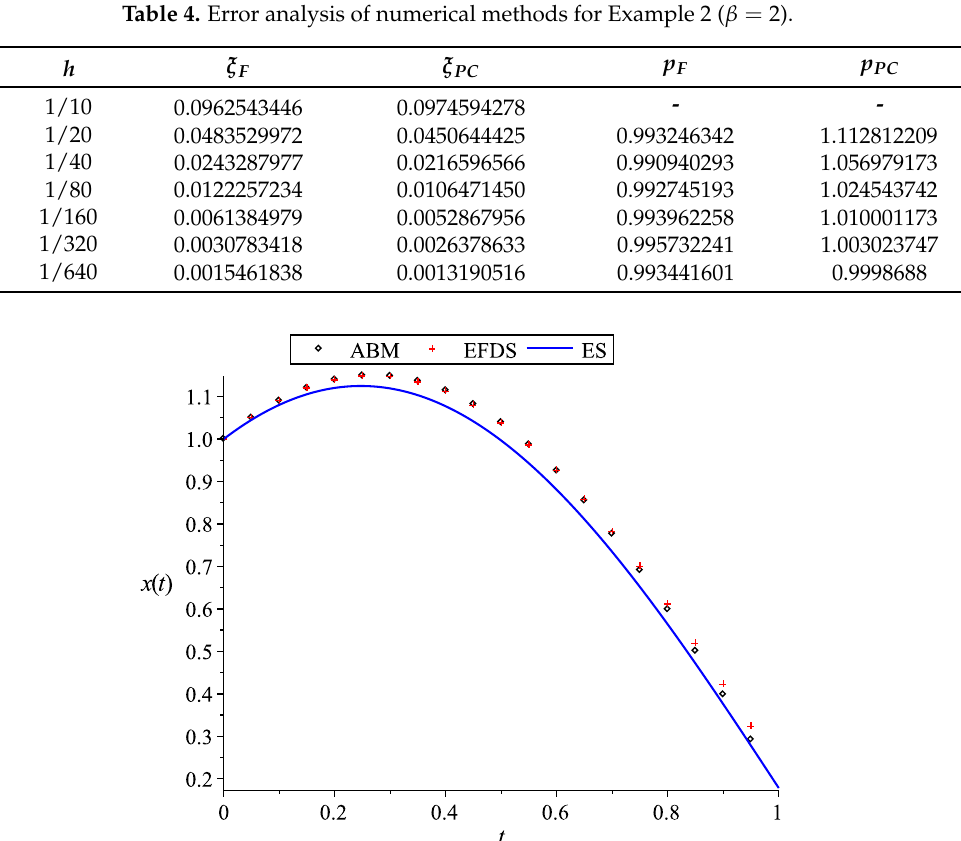
Figure 2. Numerical results using fractional Adams–Bashforth–Moulton (ABM) and explicit non-local finite-difference scheme (ENFDS) methods compared to exact solution (ES) for Example 2 at N = 20 and β =